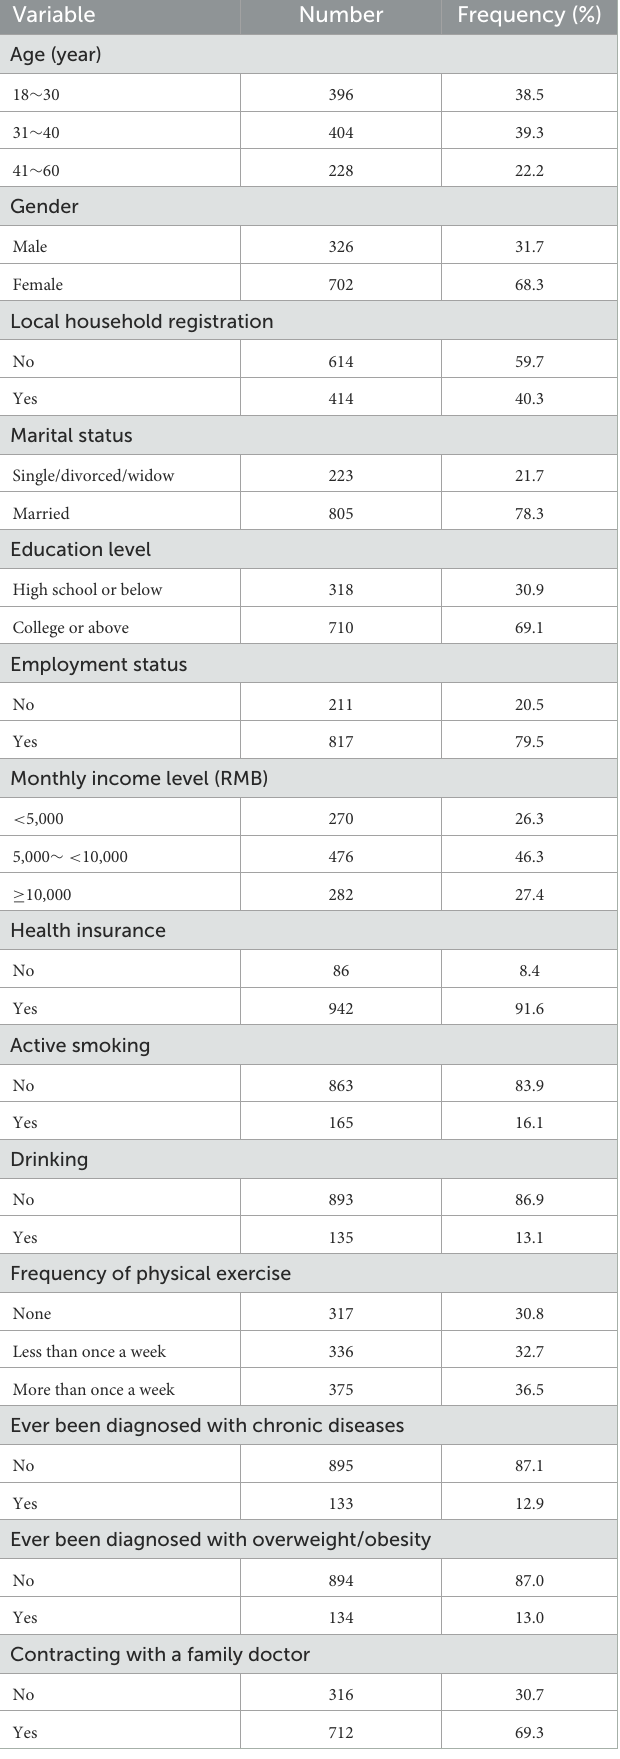
TABLE 1 Characteristics of all participants ( N =